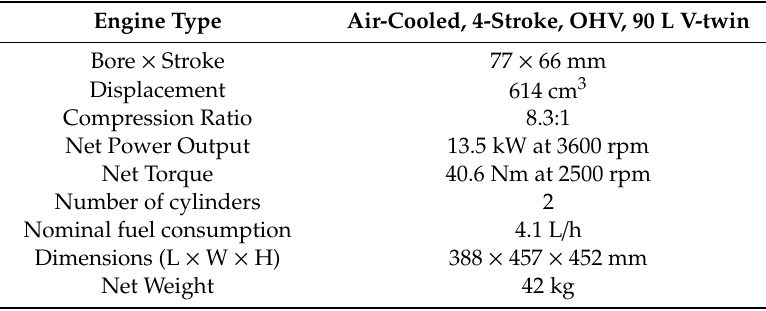
Table 1. Main specifications of the spark ignition